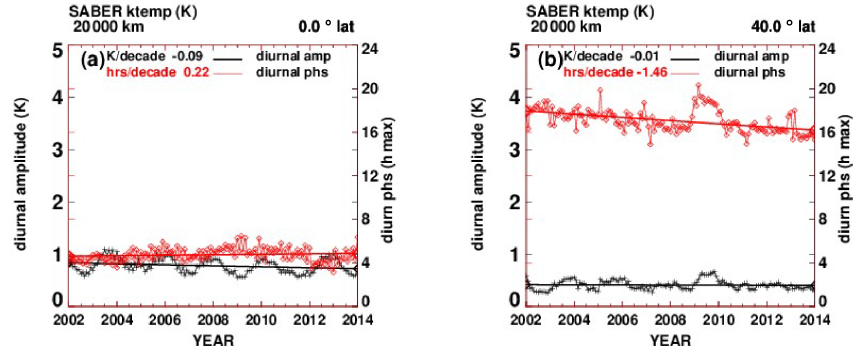
Figure A1. (a) Temperature tidal diurnal amplitudes and phases at 20km and the Equator. On the left axis scale, black line: tidal diurnal amplitude (K). On the right axis scale, red line: diurnal phase (h of maximum value). (b) As in (a) but at 40 ◦ N latitude.